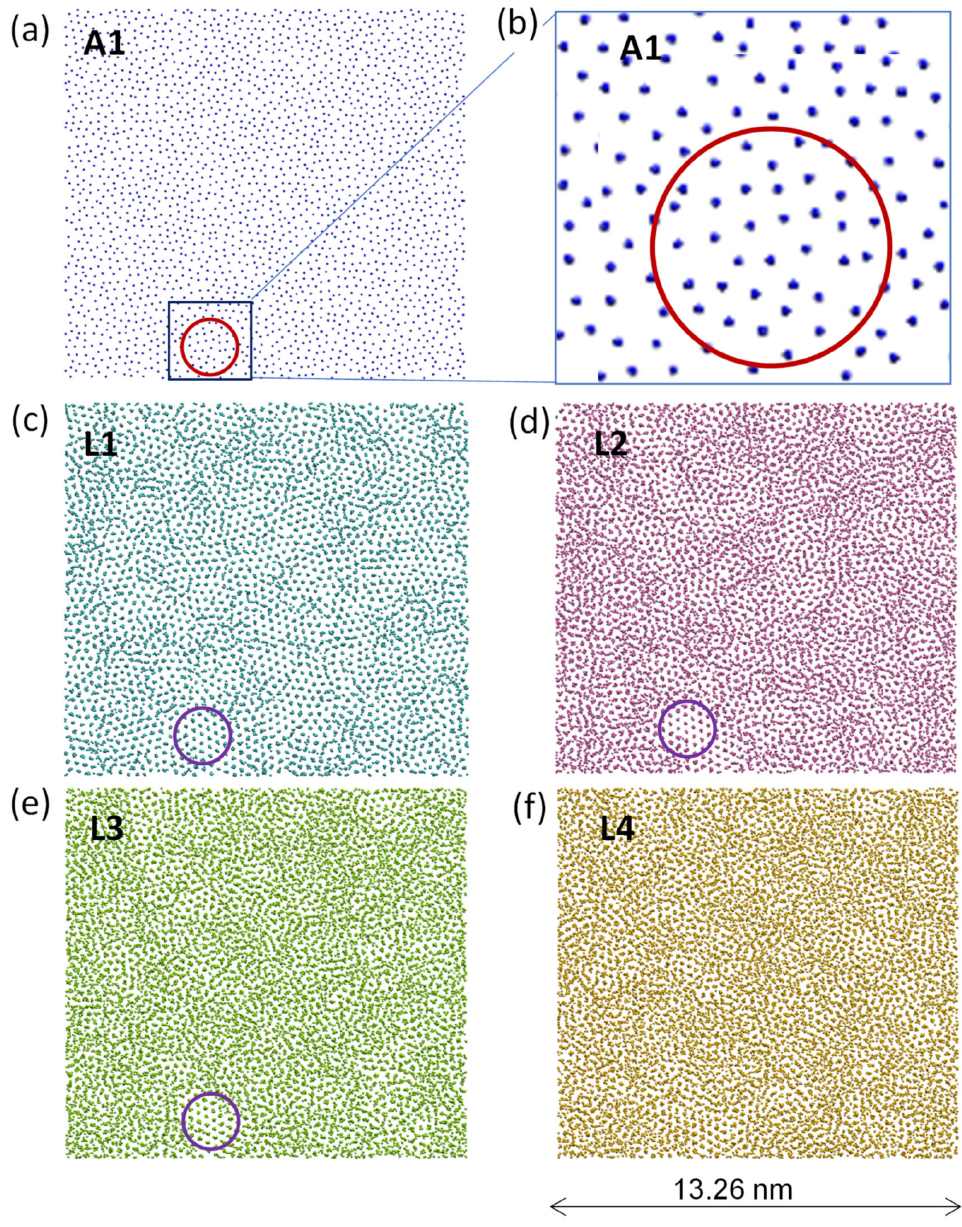
Figure 17. Heterogeneous nucleation on 2D amorphous substrate. Time averaged atomic positions ( a ) the 2D amorphous substrate (A1), and ( c – f ) the first 4 atomic layers (L1–L4) at t = 10 ps showing the heterogeneous formation of a solid particle on the 2D amorphous substrate at an undercooling of ∆ T n = 311 K. The 2D amorphous substrate was created by quenching the liquid Al from 900 K. A 2D nucleus of r n = 0.91 nm (marked with purple circles) was formed on a patch (the red circle) in the substrate surface A1. The substrate patch is magnified to show the atomic arrangement in the patch in ( b